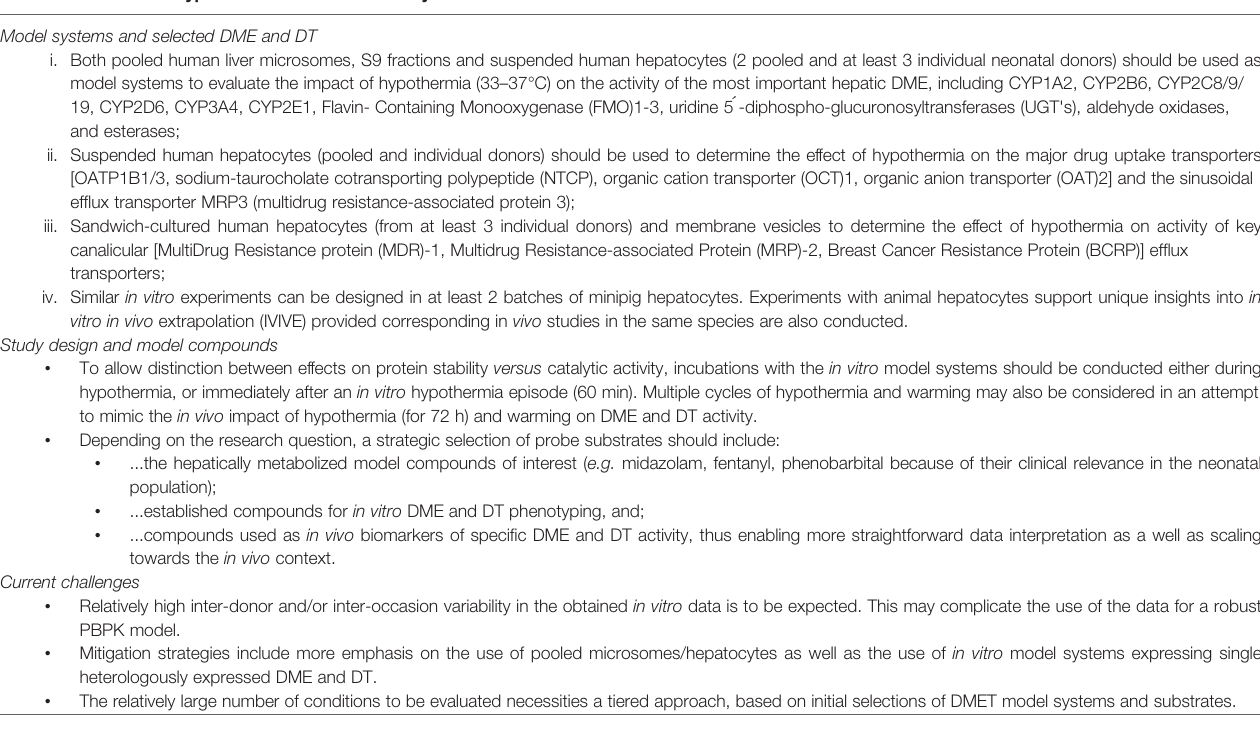
TABLE 3 | Proposed experimental conditions for in vitro evaluation of the immediate versus delayed effects of hypothermia on activity of drug metabolizing enzymes (DME) and drug transporters (DT). Immediate effects of hypothermia on in vitro activity of DME and DT Model systems and selected DME and DT i. Both pooled human liver microsomes, S9 fractions and suspended human hepatocytes (2 pooled and at least 3 individual neonatal donors) should be used as model systems to evaluate the impact of hypothermia (33 – 37°C) on the activity of the most important hepatic DME, including CYP1A2, CYP2B6, CYP2C8/9/ 19, CYP2D6, CYP3A4, CYP2E1, Flavin- Containing Monooxygenase (FMO)1-3, uridine 5 ́ -diphospho-glucuronosyltransferases (UGT's), aldehyde oxidases, and esterases; ii. Suspended human hepatocytes (pooled and individual donors) should be used to determine the effect of hypothermia on the major drug uptake